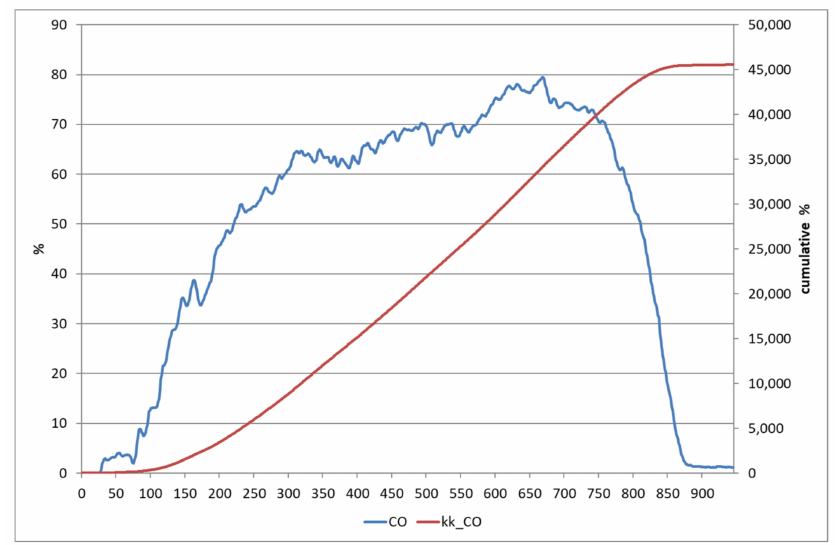
Figure 3. The behavior of %CO and cumulative %CO ( kk_CO ) in converter gas.